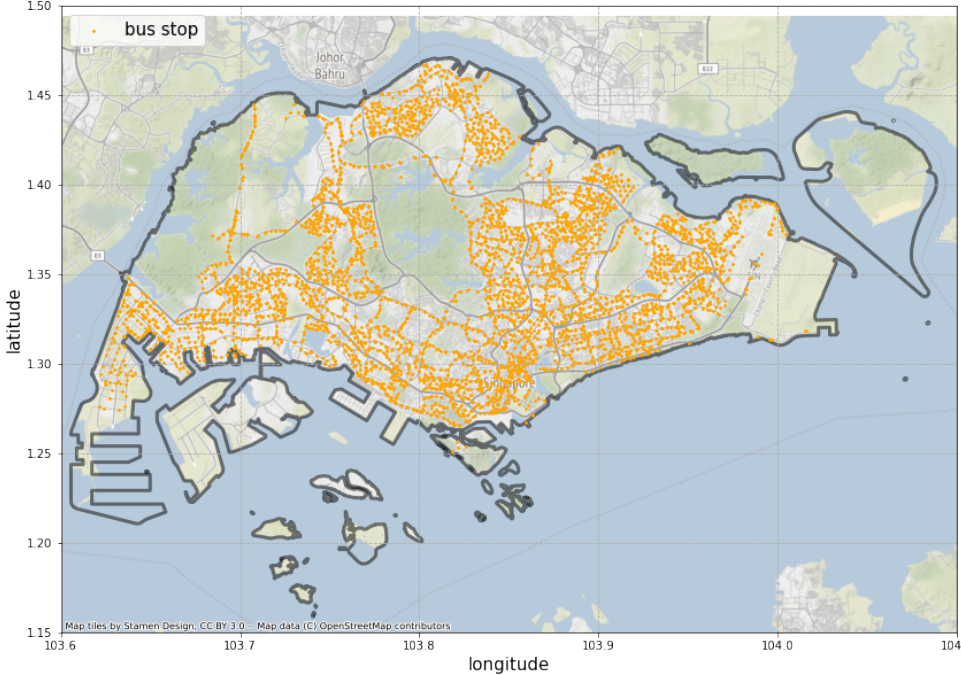
Figure 3. The distribution of bus stations in